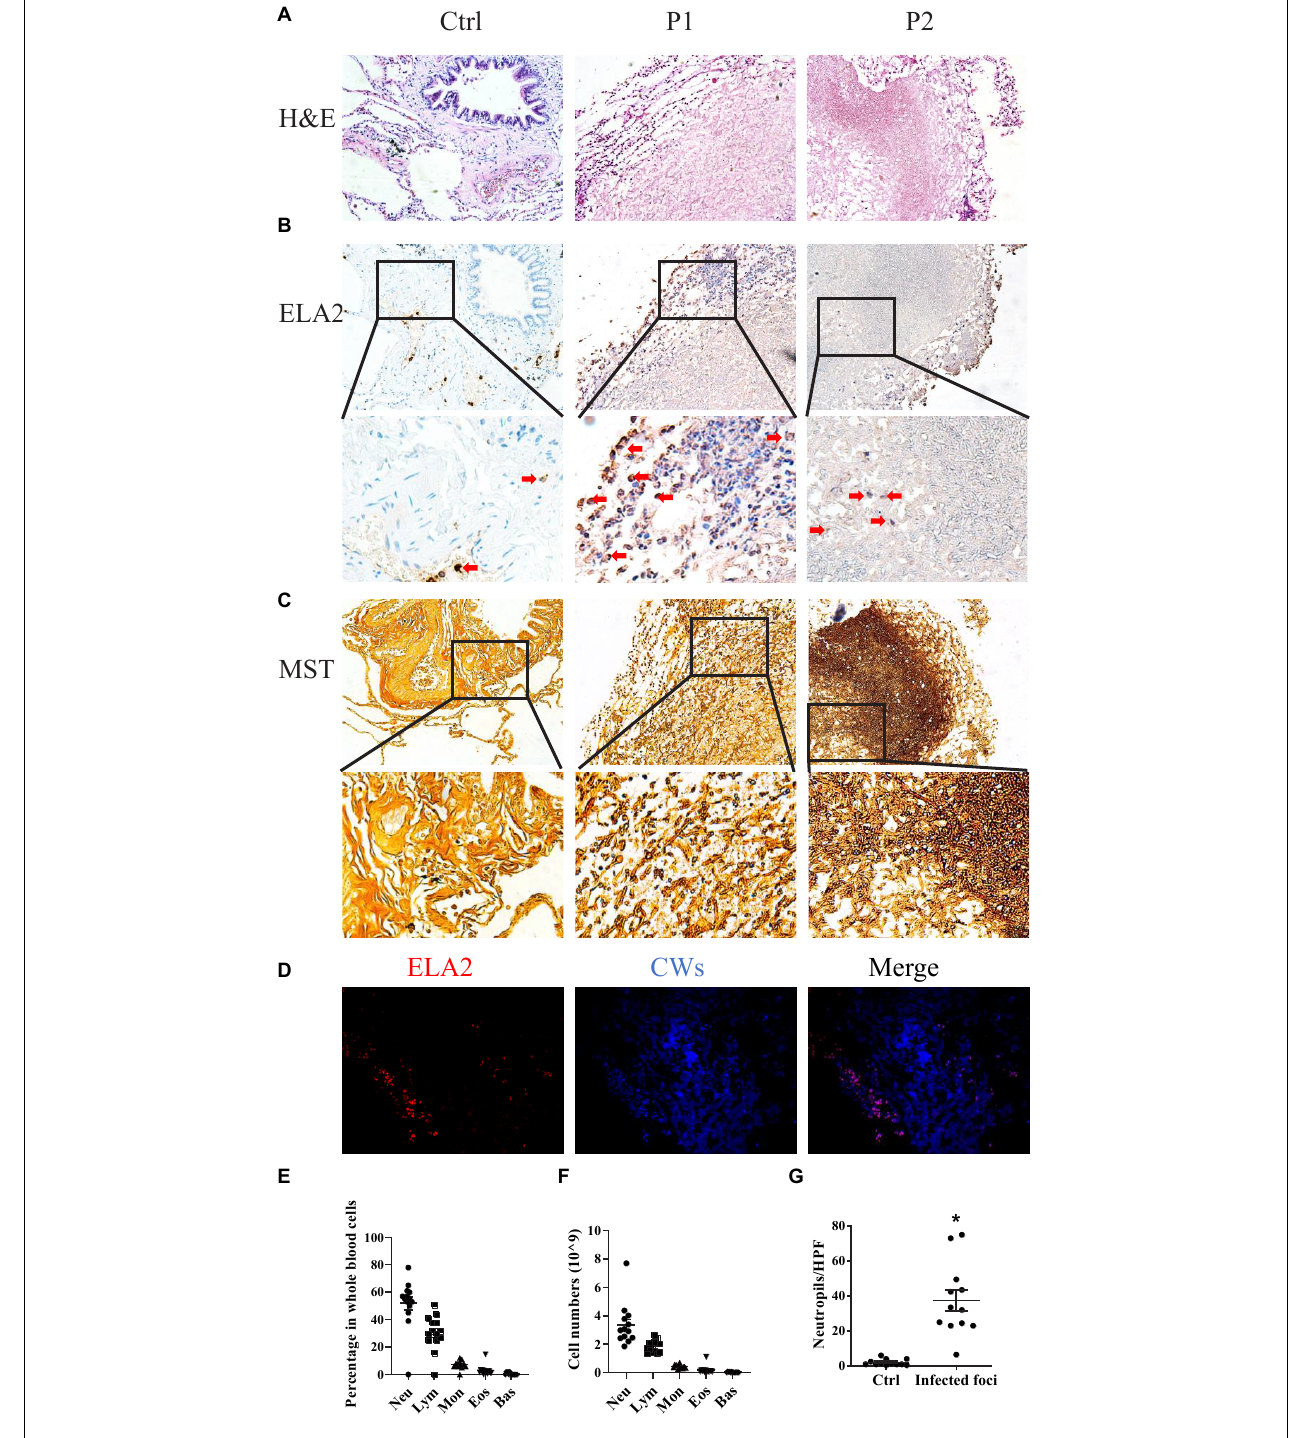
FIGURE 1 | Neutrophils are involved in Aspergillus ( A). fumigatus infection. Lung tissues obtained from patients with mold infection in the lungs were stained with (A) hematoxylin and eosin (H&E) staining, (B) immunohistochemical staining for human neutrophil elastase (ELA2), and (C) methenamine silver staining (MST). (D) Immunofluorescence staining for ELA2 and Calcofluor white staining (CWS) in lung tissue samples with Aspergillus spp. infections. Leukocyte percentages (E) and numbers (F) in the peripheral blood of patients with Aspergillus spp. infections. (G) Neutrophil numbers in the lung tissue sections were counted. Ctrl, lung tissue sections free from Aspergillus spp. Infection; P1 and P2, lung tissue sections with Aspergillus spp. infections. HPF, high power field. * p < 0.05. Original magnification × 100. The red arrow indicates neutrophils.